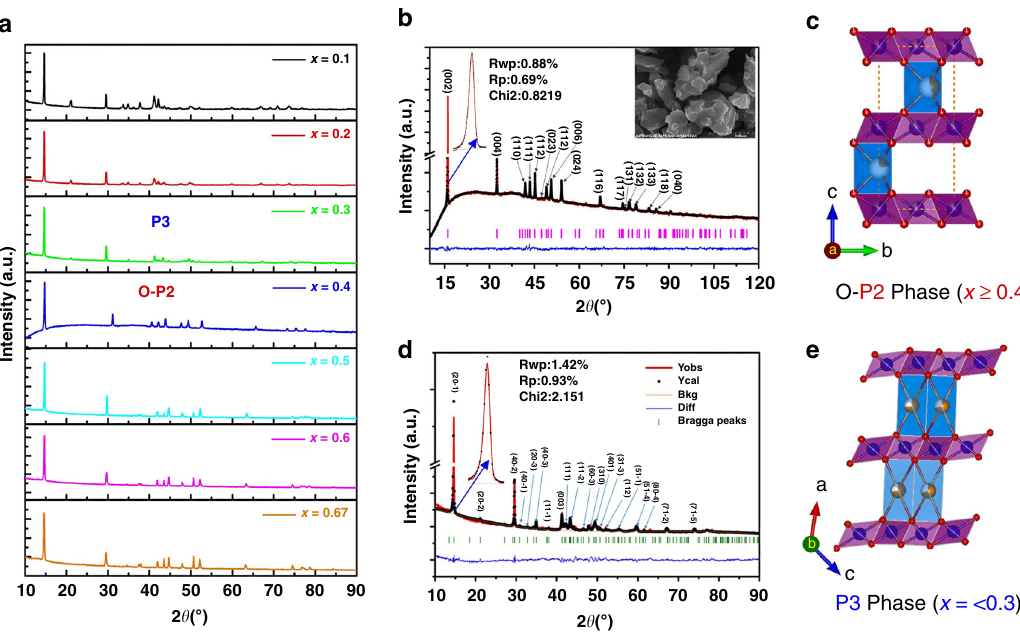
Fig. 2 Structure of K x Ni x/2 Mn 1 − x/2 O 2 . a XRD patterns of K x Ni x /2 Mn 1 − x /2 O 2 compounds prepared by solid state reaction, arranged in order of increasing potassium content from top to bottom ( λ = 1.789 Å). b The Rietveld re fi nement for the K 0.4 Ni 0.2 Mn 0.8 O 2 XRD pattern. c Schematic illustration of the orthorhombic P2-K 0.4 Ni 0.2 Mn 0.8 O 2 projected in b – c plane. d The Rietveld re fi nement for the K 0.3 Ni 0.15 Mn 0.85 O 2 XRD pattern. e Schematic illustration of the Monoclinic K 0.3 Ni 0.15 Mn 0.85 O 2 projected in a – c